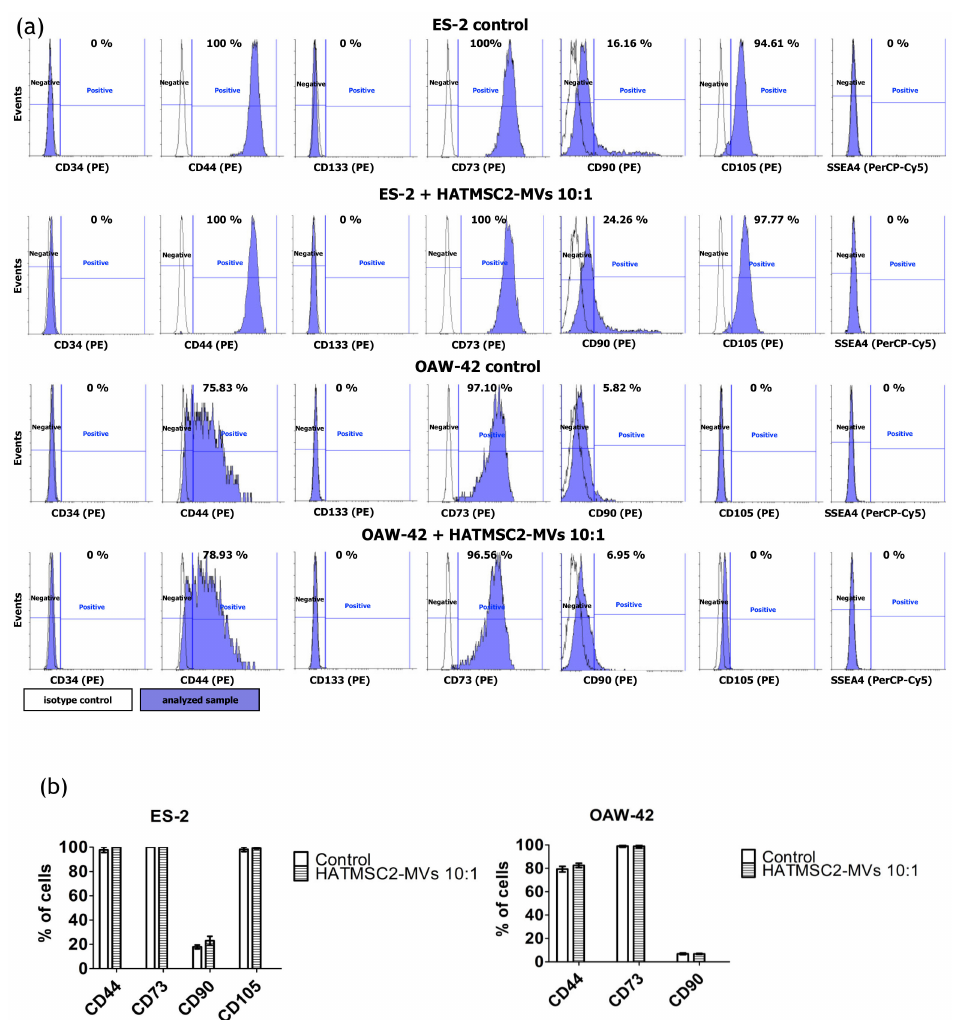
Figure 7. Characteristics of human ovarian cancer cell lines before and after HATMSC2-MV treatment at di ff erent ratios. ( a ) Representative histograms of flow cytometry analysis for surface markers (CD34, CD44, CD133, SSEA4, CD73, CD90, and CD105) on the ES-2 and OAW-42 cell lines. The cells were stained with selected antibodies conjugated with fluorochromes. Blue filled histograms correspond to ES-2 and OAW-42 cells, labeled with defined antibodies, and empty histograms represent the isotype controls. ( b ) The percentages of cells positive for selected markers were determined using Flowing Software 2. The data represent mean ± SEM values from three independent